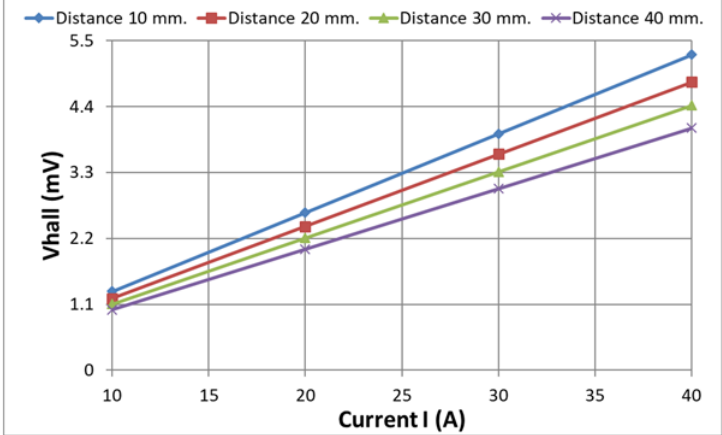
Figure 14. Dependence of the Hall plate voltage Vhall on the current for different distances to the conductor.